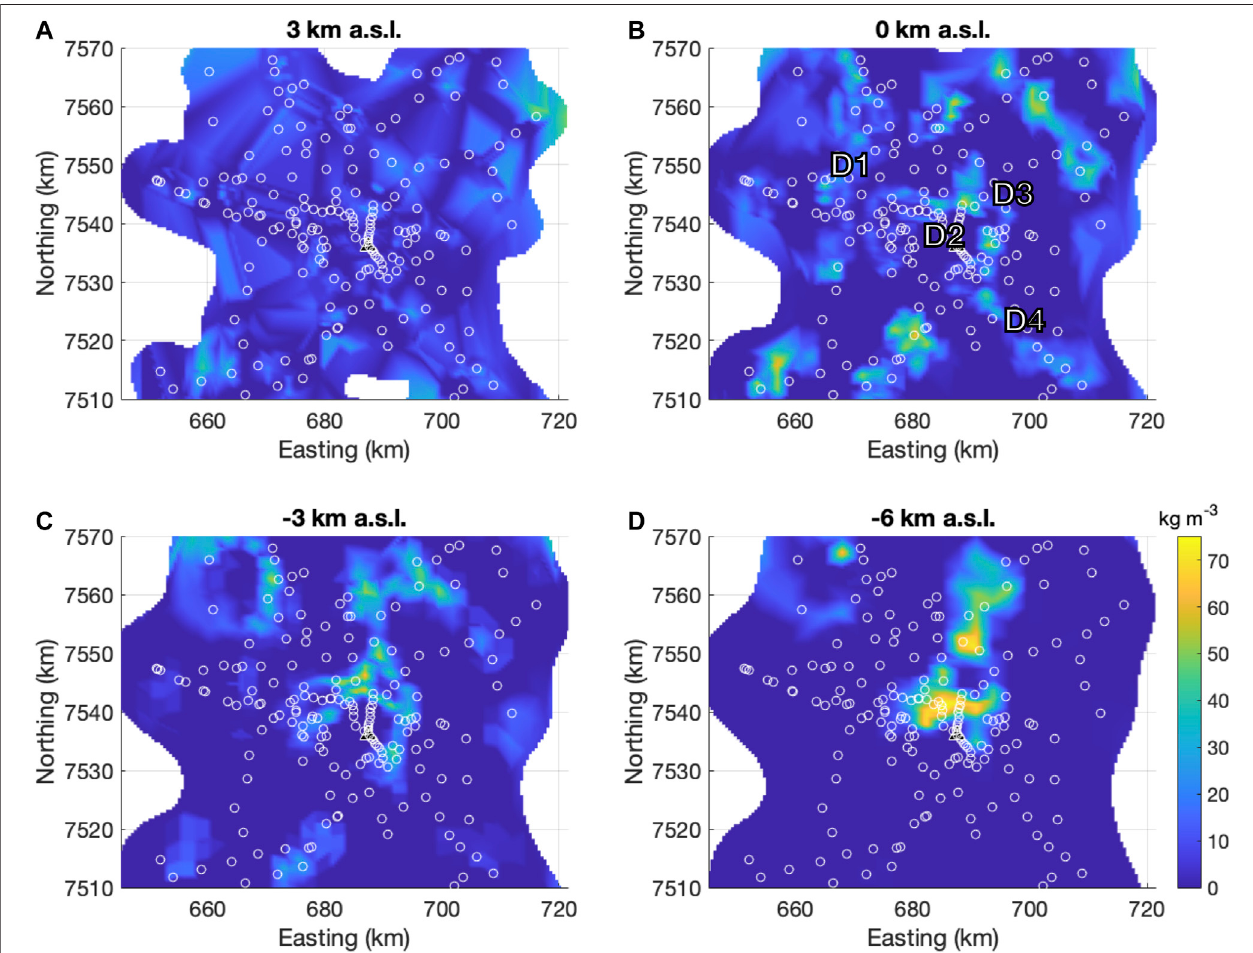
FIGURE7| Depthslicesofthebootstrapsensitivityanalysis.Colorbarreferstothestandarddeviationacrossallmodelsintheanalysis.Depthsareinkmabovesea level (a.s.l.). Black triangle marks the location of Uturuncu, and white circles are gravity measurement locations used in the inversion.